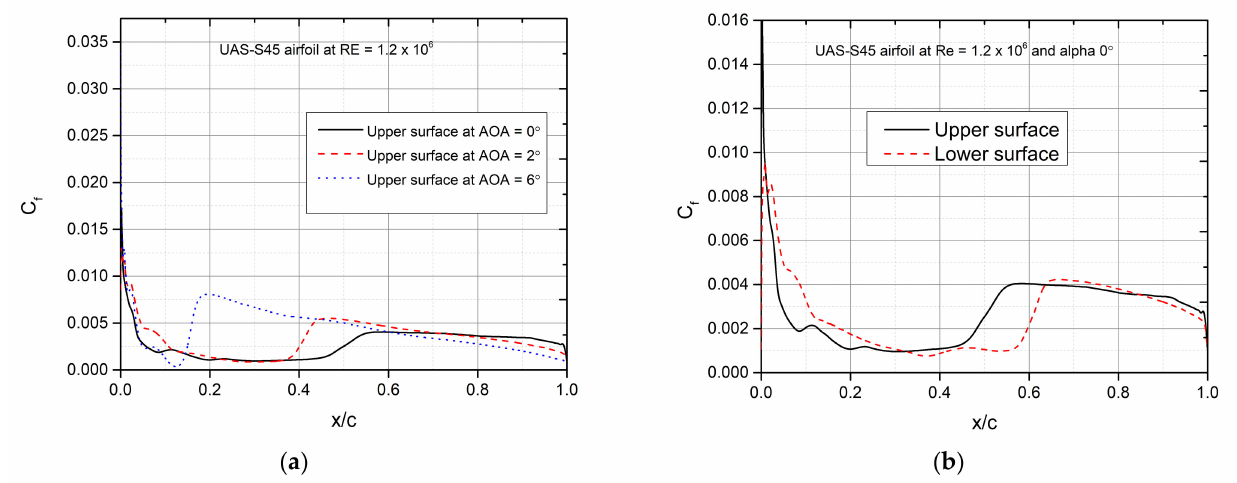
Figure 9. Skin friction coefficients variations with the chord obtained at different angles of attack. ( a ) the friction coefficient variations with the chord for the angles of attack of 0 ◦ , 2 ◦ and 6 ◦ ; ( b ) the initial flow separation, the separated region and its reattachment for upper and lower surface.